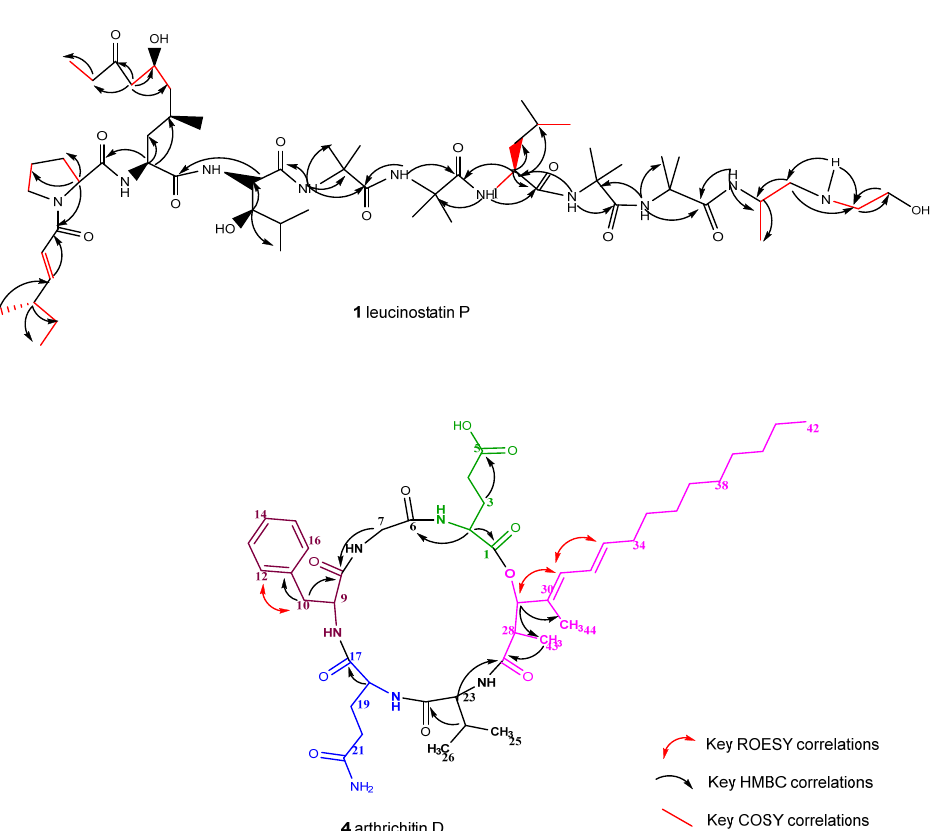
Figure 2. 2D NMR correlations of compounds 1 and 4 from Ijuhya vitellina.